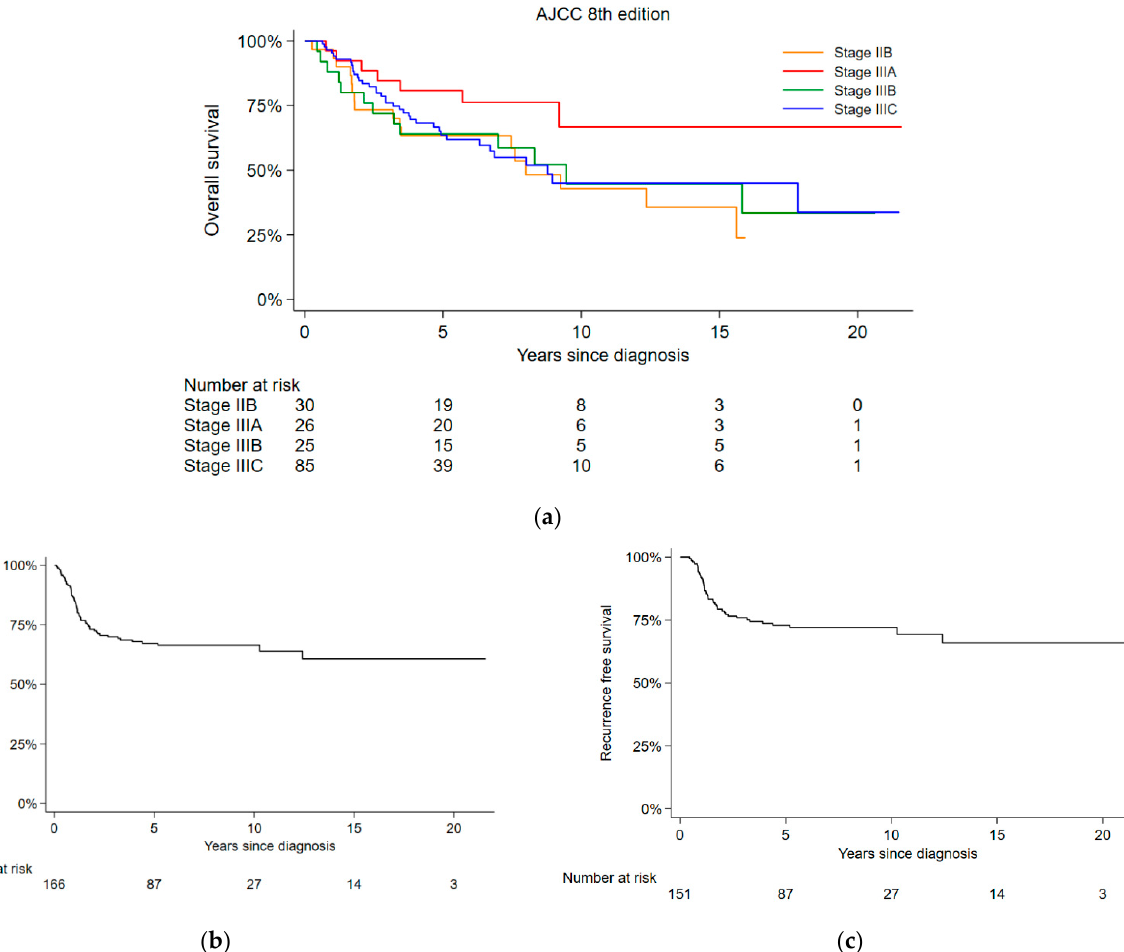
Figure 2. Kaplan–Maier survival curves. ( a ) Overall survival by stages ( n = 166); ( b ) disease-free survival ( n = 166); ( c ) recurrence-free survival in patients completing combined curative treatment ( n = 151).